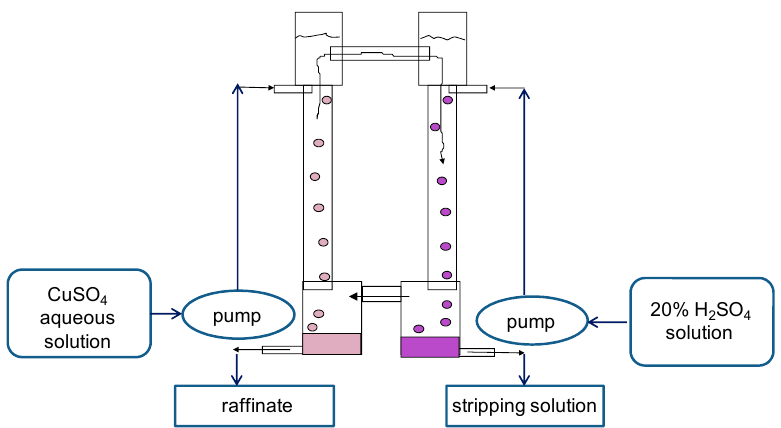
Figure 4. Scheme of the experimental setup of the small two-column extraction apparatus. Columns have a diameter of 30 mm and a height of 400 mm. To extract copper from sulfuric acid solution, a 20% solution of LIX-84 in dodecane was used as an organic membrane phase, and a 20% solution of sulfuric acid was used as a stripping